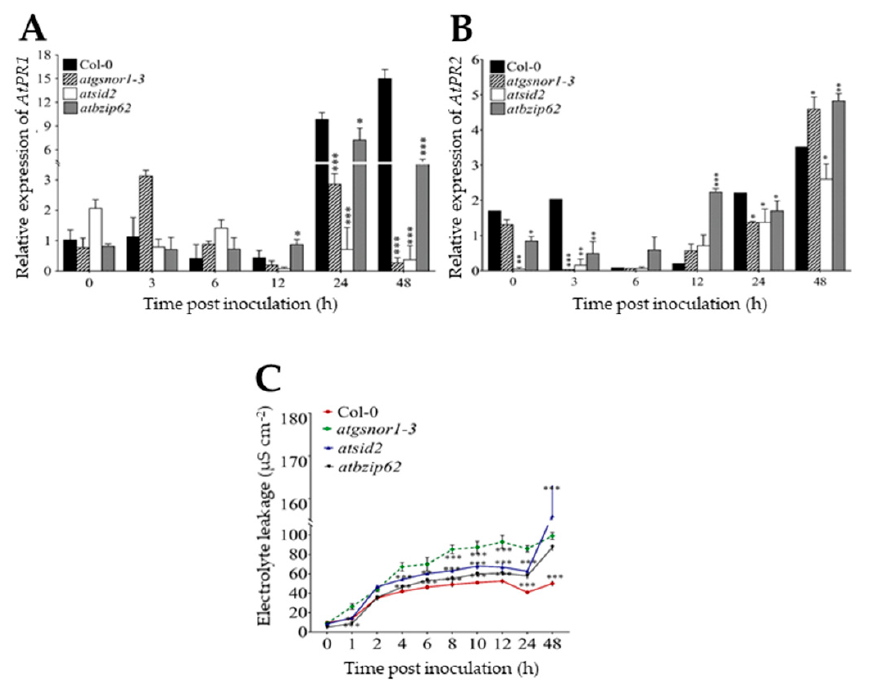
Figure 2. Transcript accumulation patterns of pathogenesis-related genes and electrolyte leakage results. Expression level over time of ( A ) AtPR1 and ( B ) AtPR2 in local leaf samples of Col-0 (WT), and atgsnor1-3, atsid2 , and atbzip62 mutant lines in response to Pst DC3000 vir for R genes-mediated resistance soon after bacterial inoculation. ( C ) Electrolyte leakage measured over time. Data are the mean expression values in triplicate normalized to the relative expression of AtActin1 . * p < 0.05; ** p < 0.01; *** p < 0.001; empty are